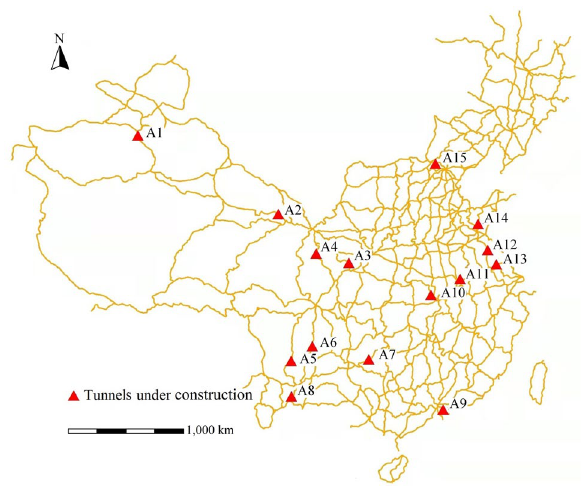
Fig. 2 Layout of selected tunnels under construction. See Table 3 for the name and other information of the 15 tunnels.